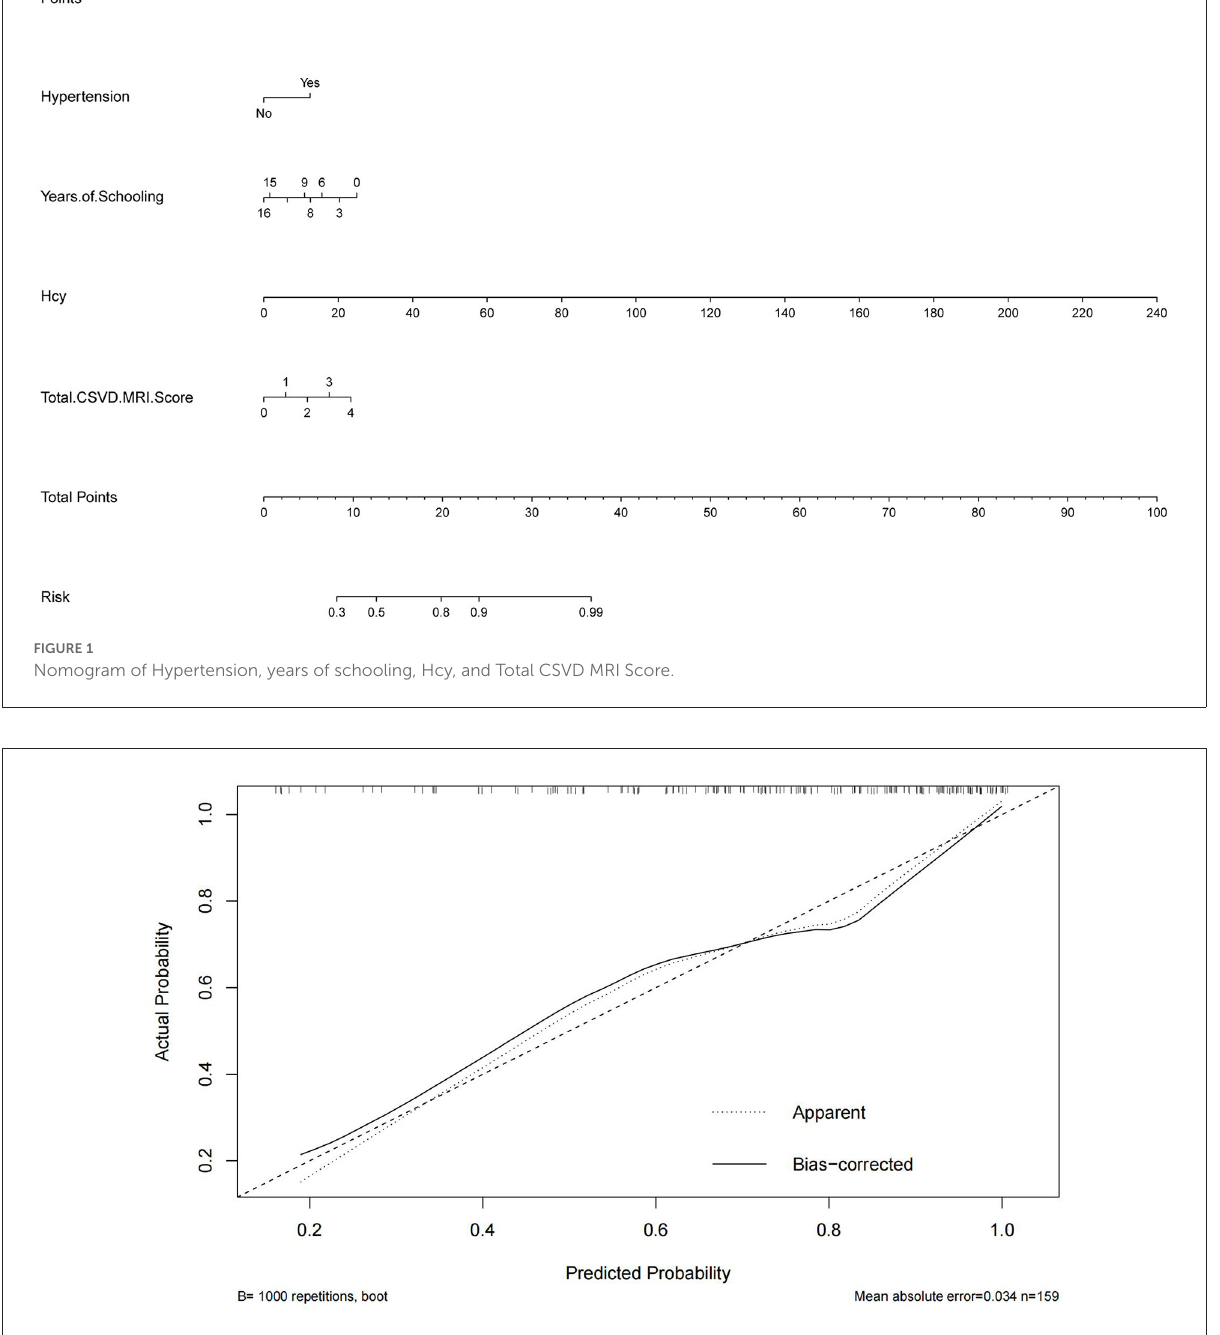
FIGURE2 Calibration curve for internal validation of the